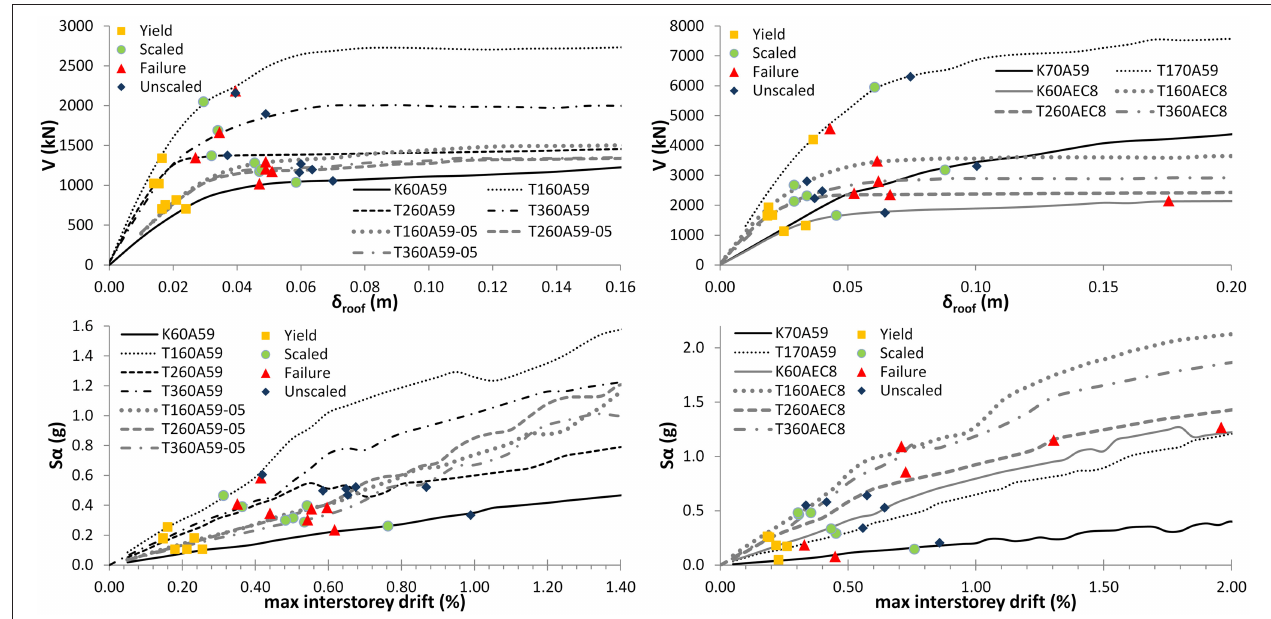
FIGURE 11 | Comparison of the median IDA intensity curves for the bare and infill frames considered in terms of the dr global